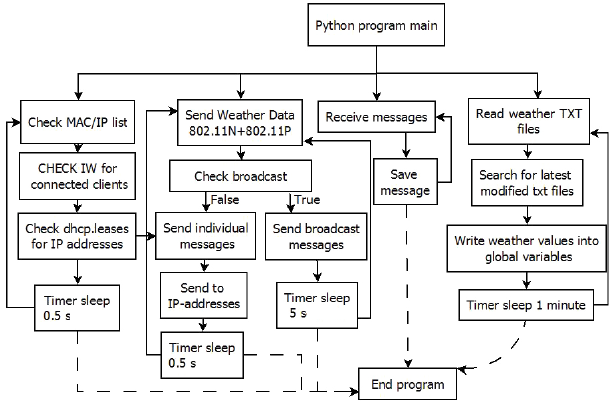
Figure 4. Operational process in